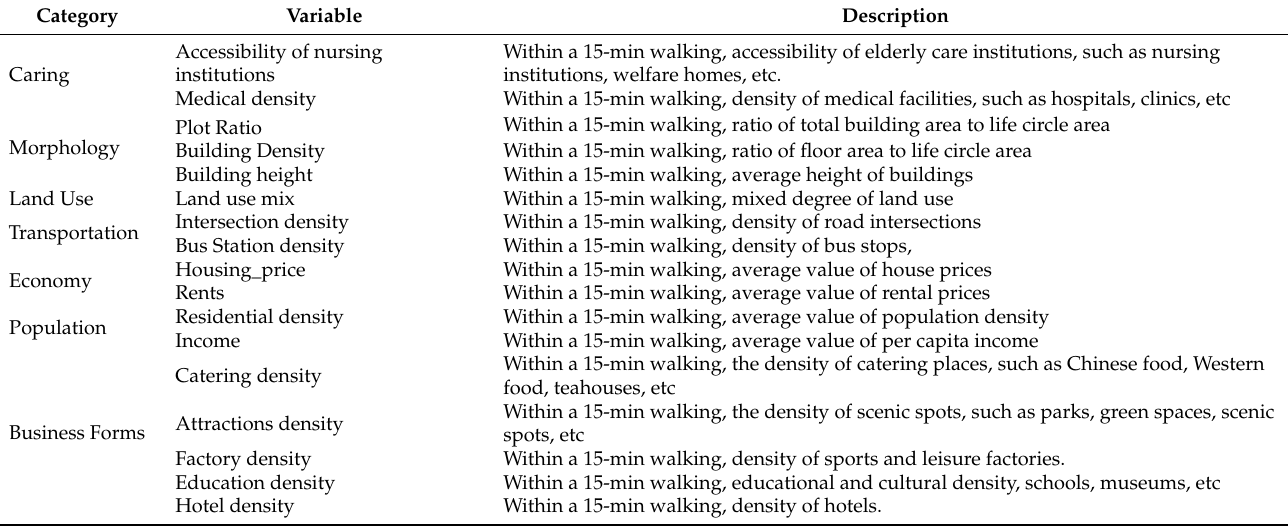
Table 1. Influencing factors of spatial distribution